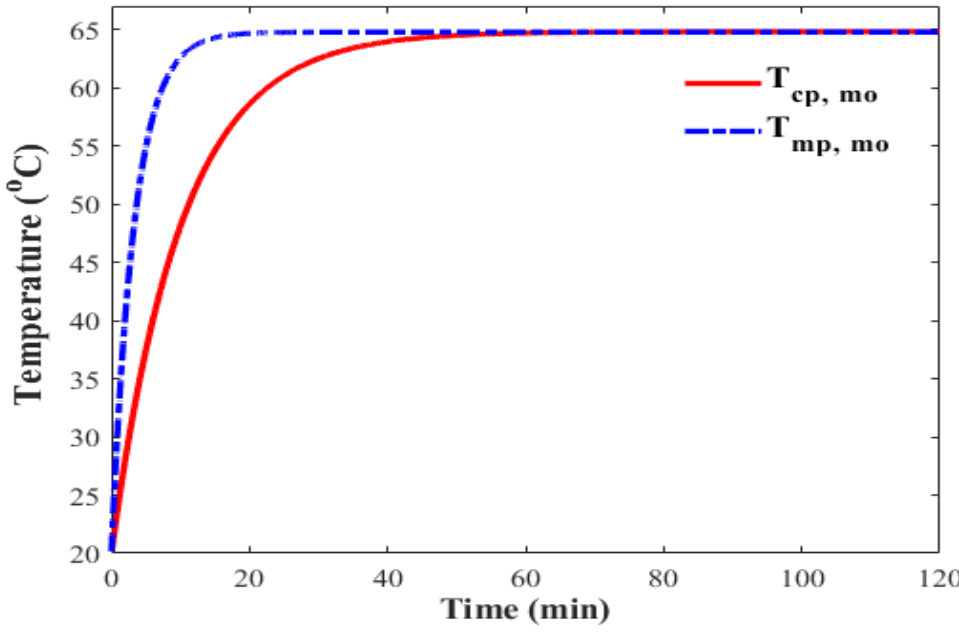
Figure 9. Mean outlet temperatures of the main pipe ( T mp,mo ) and connecting pipe ( T cp,mo ). The effects of the feed rate of the hot saline (through the hot flow chamber) and cold fluid (through the cold flow chamber) on the permeate are shown in Figures 10 and 11.